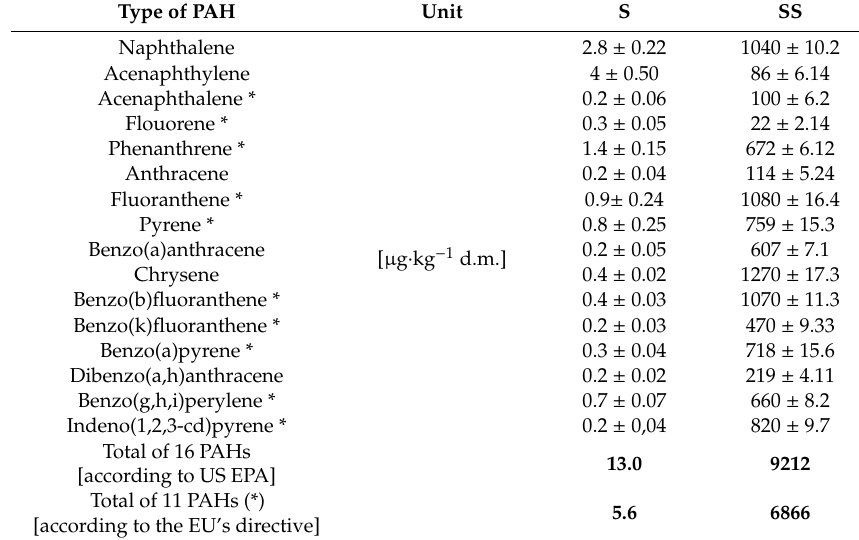
Table 2. Contents of polycyclic aromatic hydrocarbons (PAH) in soil and sewage sludge used in the lysimeter